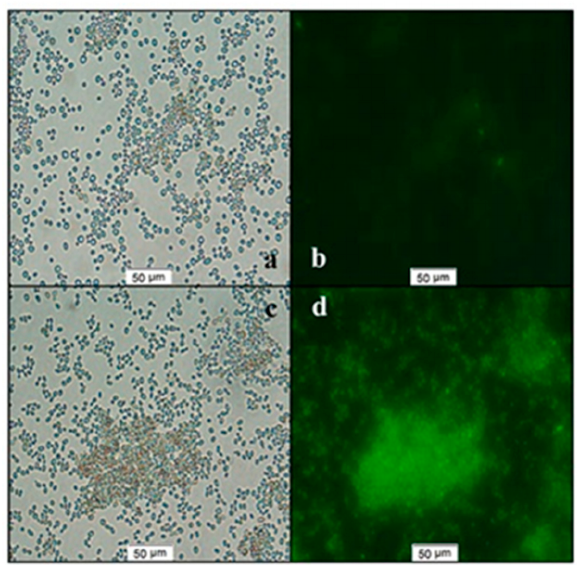
Figure 2. Bright-field and fluorescent micrograph of yeast cells with biosynthesized QDs. The yeasts were growing in normal TGY ( a , b ) and tryptone-supplemented TGY ( c , d ) medium with both precursors (CdCl 2 and Na 2 SeO 3 ).